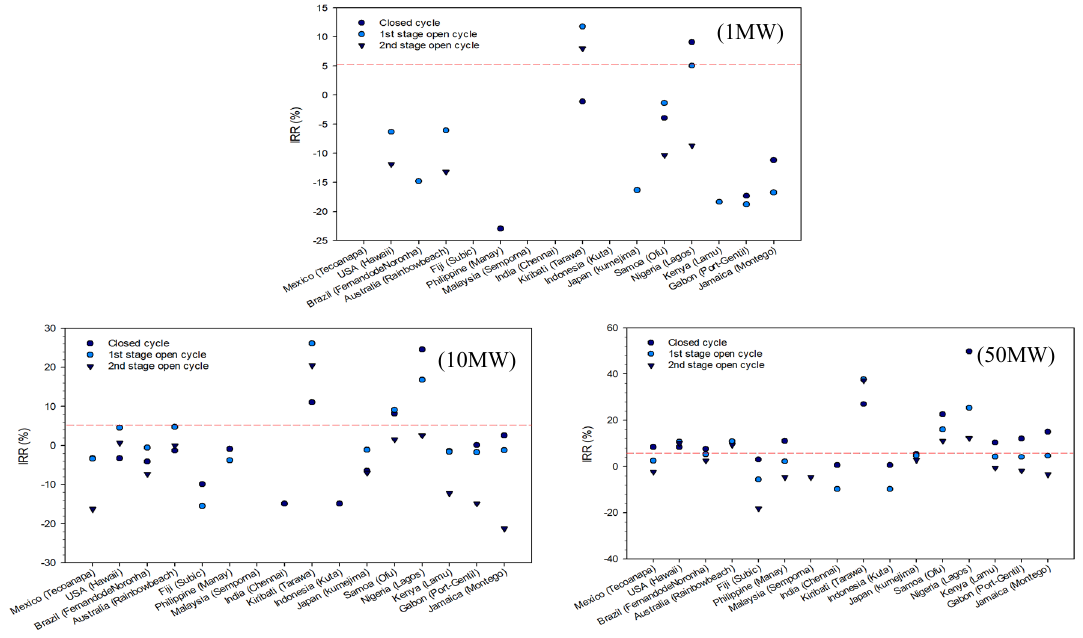
Figure 12. The internal rate of return (IRR) according to the change in capacity of OTEC.